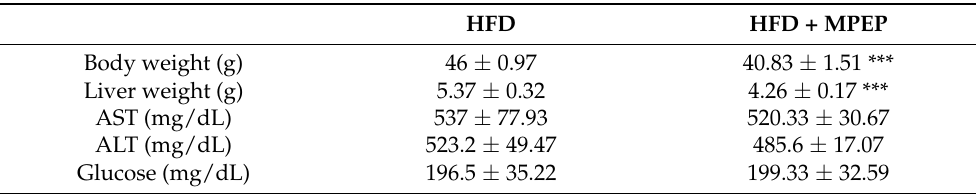
Table 1. Model characterization and liver injury evaluation.